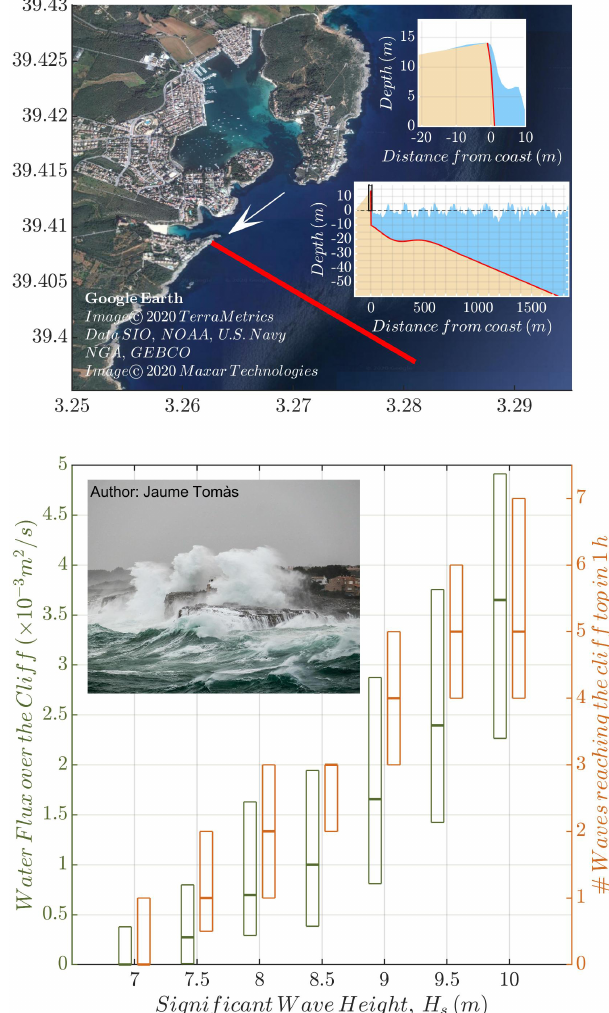
Figure 8. Upper panel: satellite image of the Portocolom area with the transect where the bathymetric profile was extracted in red. The lower inset shows one snapshot of one SWASH simulation in one moment where there is overtopping; the upper inset shows a zoom of the upper part of the cliff corresponding to the black box in the lower inset. Bottom panel: box plots of the water flux over the cliff per lineal metre (green boxes) and the number of waves reaching the top of the cliff (dark orange boxes) as a function of significant wave height. The thick line of the box plots indicates the median extracted from 100 different 1-D SWASH simulations, while the bottom and top of the boxes show quantiles 0.25 and 0.75, respectively. The in- set picture shows the waves hitting the simulated spot (white arrow in the upper panel) during the most intense time of Storm Gloria, 21 January at